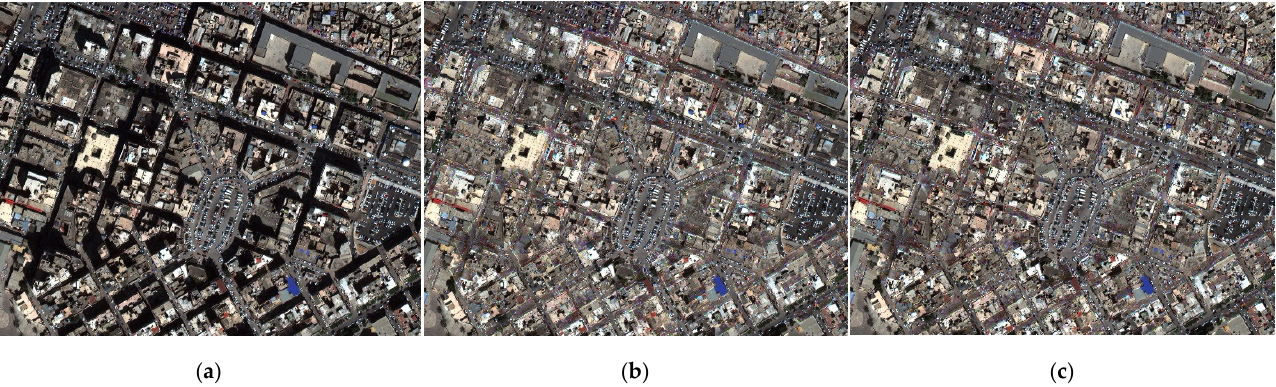
Figure 15. Results of experimental data 2: ( a ) original image; ( b ) result of shadow compensation; and ( c ) result of penumbra removal.